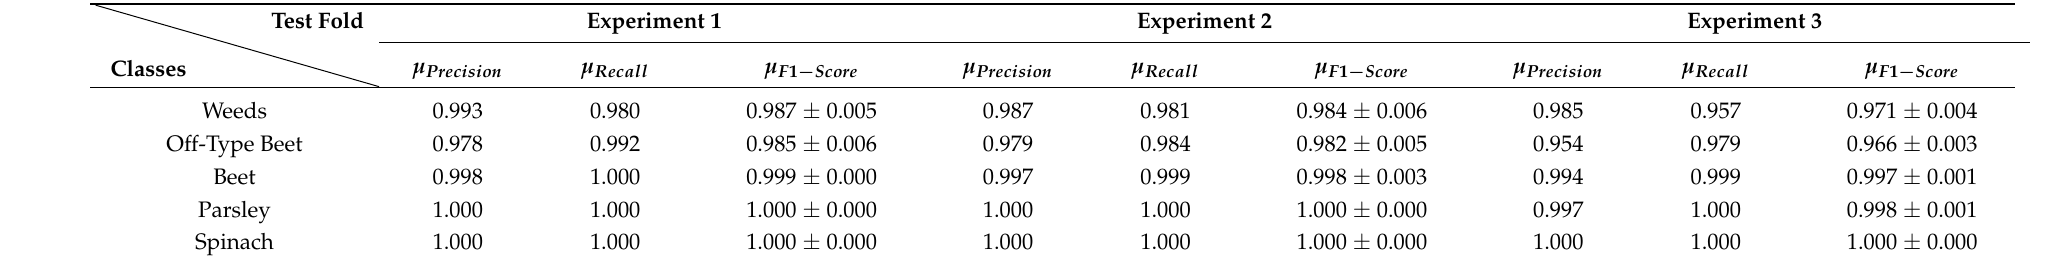
Table 4. Comparison of classification reports generated from 5-Fold cross-validation leaving k = 1 fold out while reducing training and augmenting test sample size. Where experiment 3 represents the largest test sample size Figure 11. The average precision, recall and F1-Score are reported for each class obtained with the ViT B-16